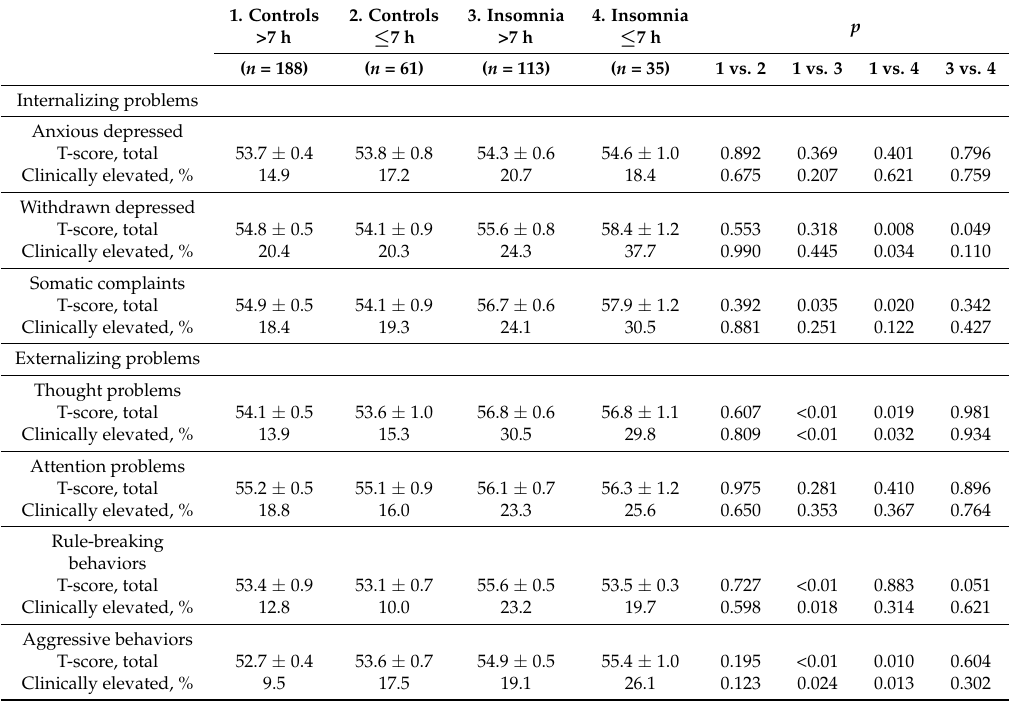
Table 2. Behavioral profiles of the sample stratified by insomnia symptoms and objective sleep duration